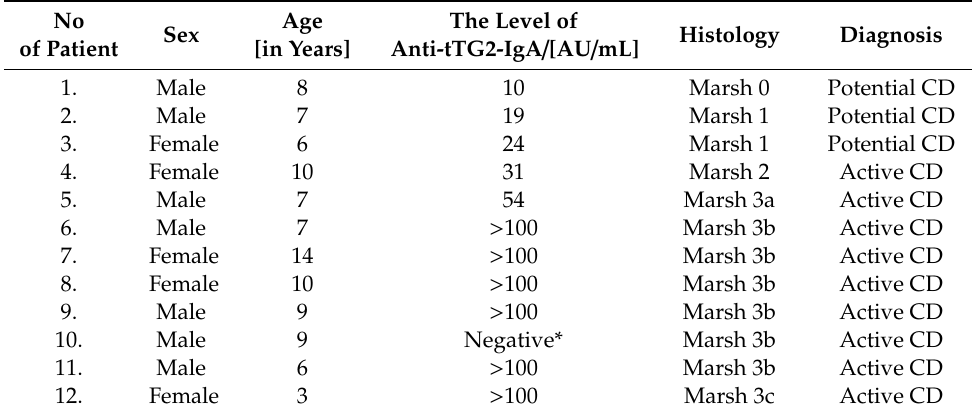
Table 2. Characteristics of CD patients enrolled in ultrastructural